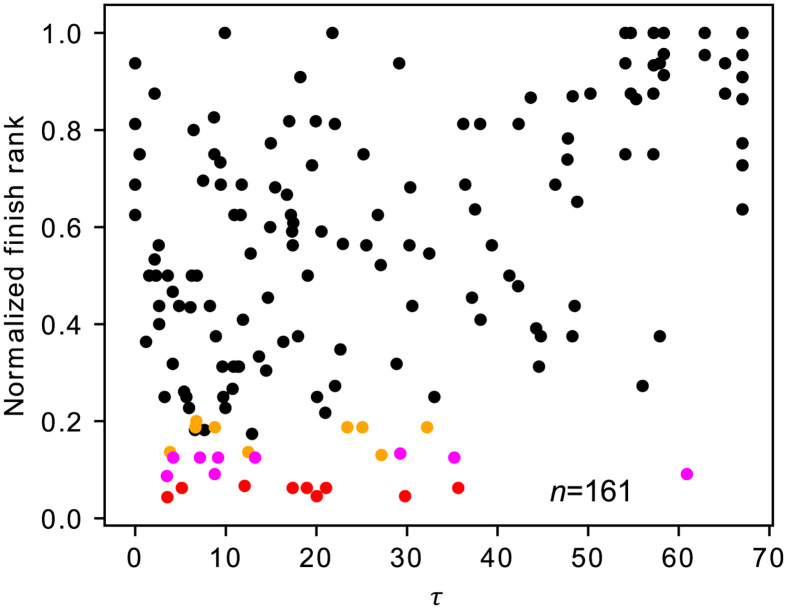
Relationships between the normalized finish rank and τ superposed over all races.The top three skaters are shown in red, magenta, and orange.